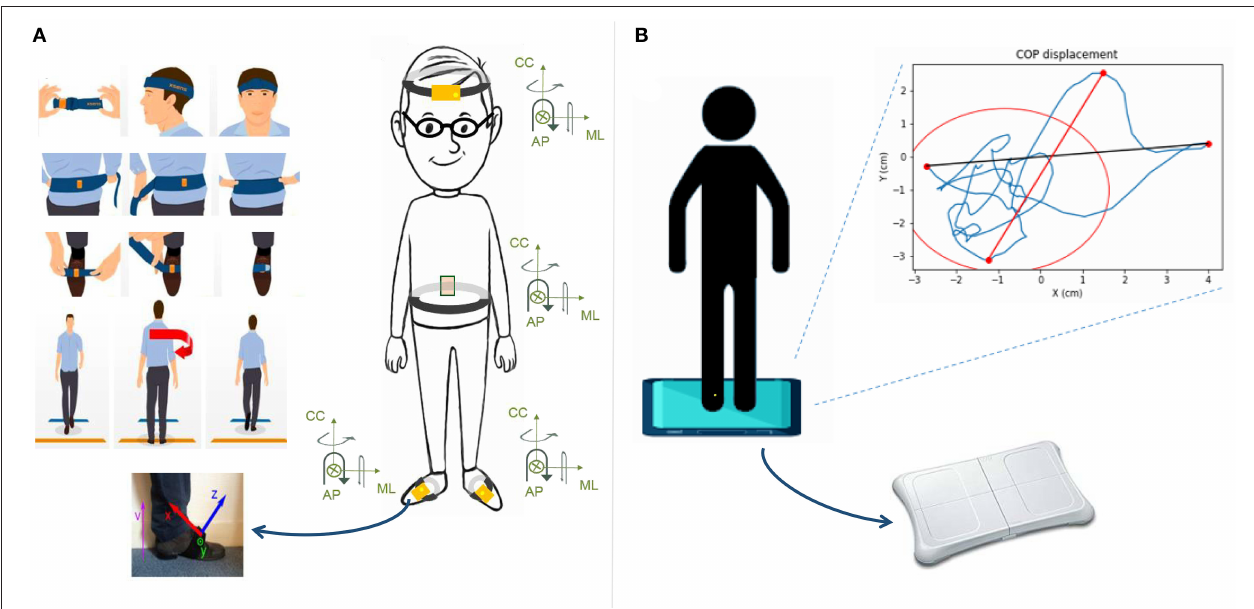
FIGURE 1 | Measurement process for balance analysis. (A) For gait analysis: Four sensors are placed on the top of each foot, on the low back, and on the front of the resident.They are asked to walk 10 m, make a U-turn and come back to the start line. The orientation of each IMU is indicated. (B) For quiet stance analysis: The force platform is a Wii Balance Board on which the participant stands and remains as still as possible for two periods of 25 s (eyes open and eyes closed). The signal of the COP trajectory is then recorded and automatically